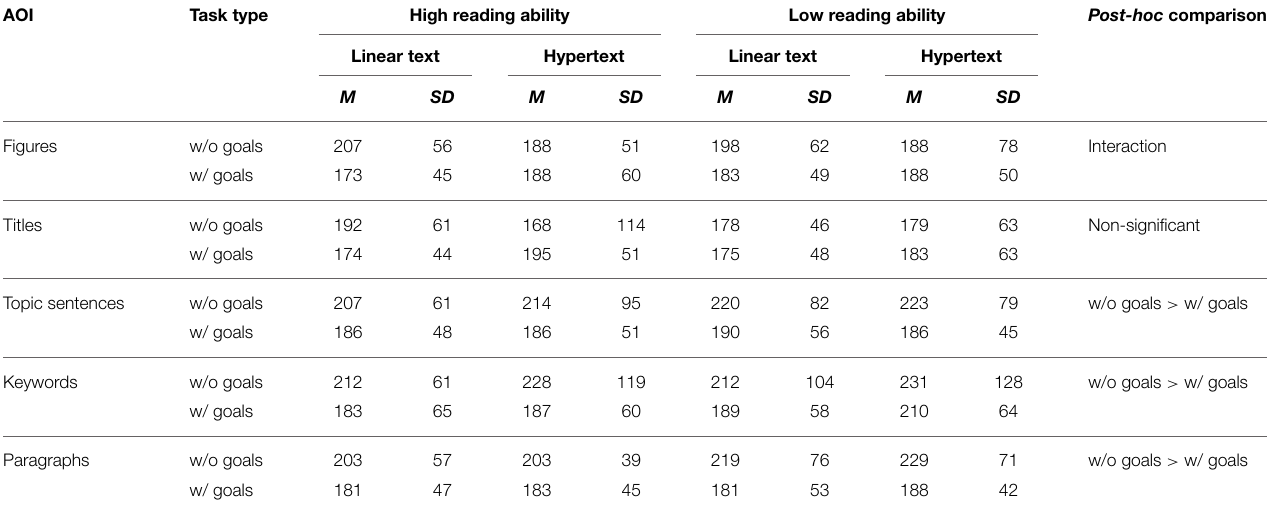
TABLE 2 | Mean and SD values of the MFD for each AOI (unit: milliseconds).